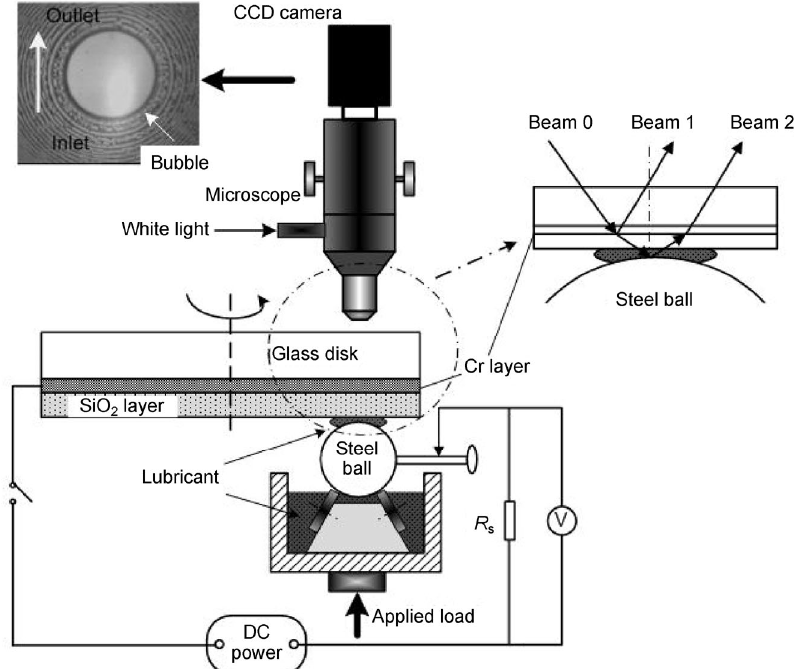
Fig. 19 The sketch of the experimental setup for TFL under external electrical field, developed by Xie et al. [91, 92]. Copyright 2004, AIP Publishing